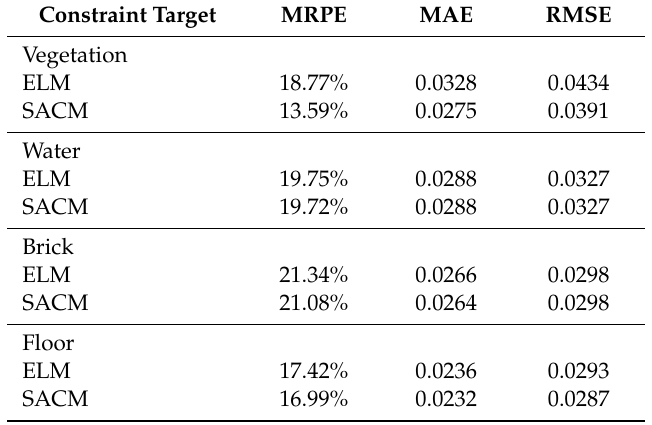
Table 7. The average error of MAE, MRPE and RMSE for di ff erent constraint targets.